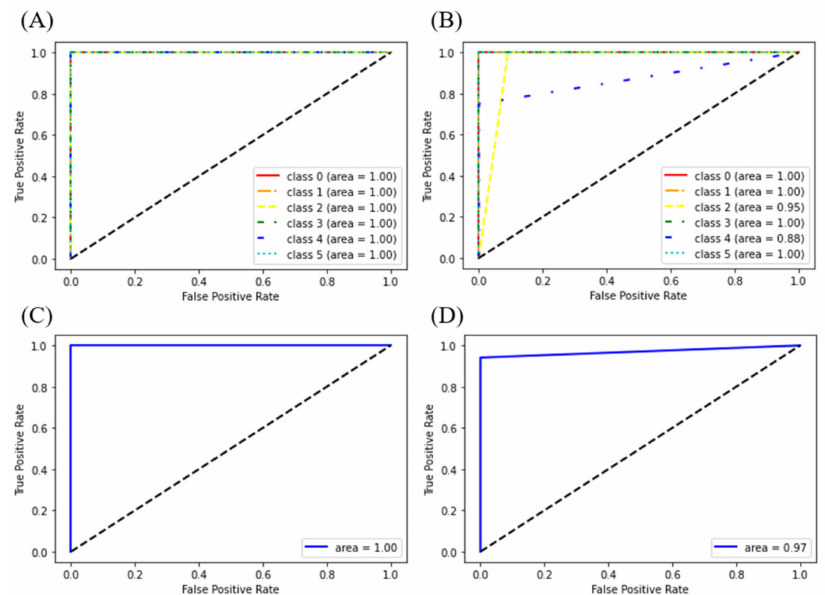
Figure 3. The receiver operating characteristic (ROC) curves of XGBoost models on the liquor dataset and the LCC dataset. Each color represents a class. ( A ) The ROC curve of XGBoost model trained by features of KPIC2 on the liquor dataset; ( B ) the ROC curve of XGBoost model trained by features of XCMS on the liquor dataset; ( C ) the ROC curve of XGBoost model trained by features of KPIC2 on the LCC dataset; ( D ) the ROC curve of XGBoost model trained by features of XCMS on the LCC